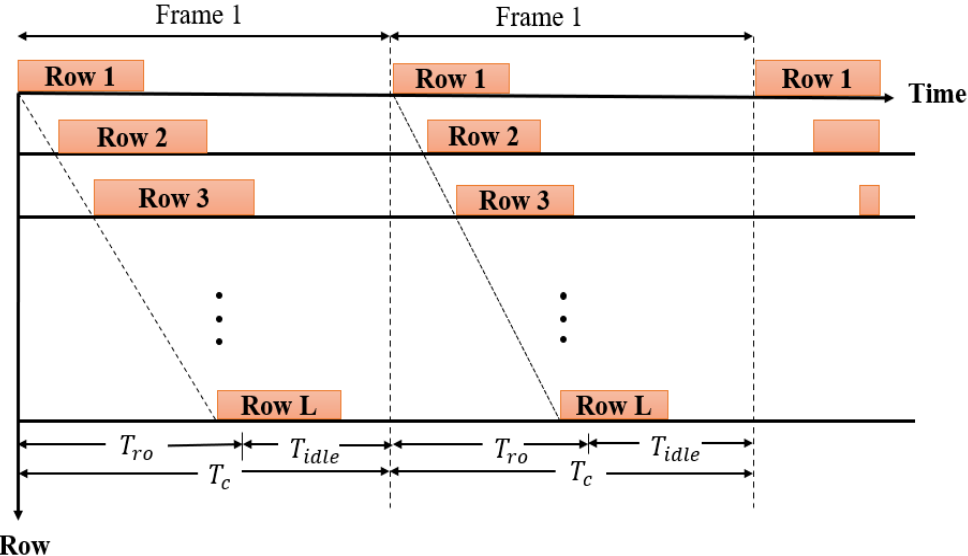
Figure 4. Rolling shutter mechanism video acquisition process [48].